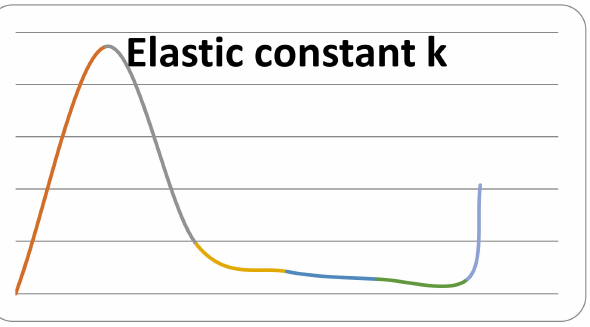
Figure 24. Value of constant k as a function of the z coordinates for the upper wire. Table 5. The values of the elastic constant k as a function of the z and y coordinates. Y